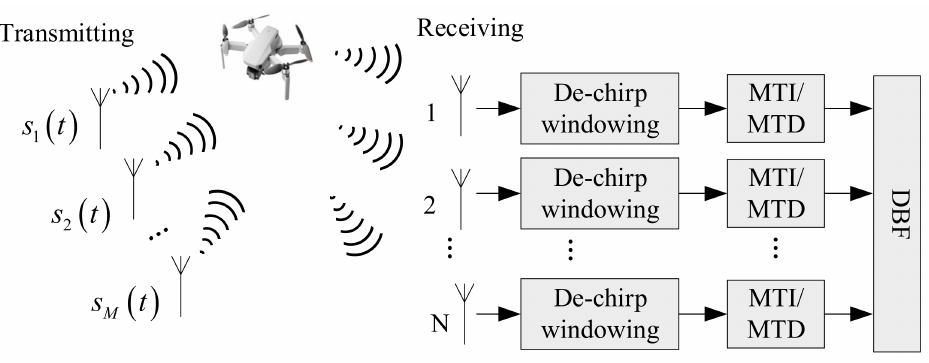
Figure 3. Flow chart of time division MIMO radar signal